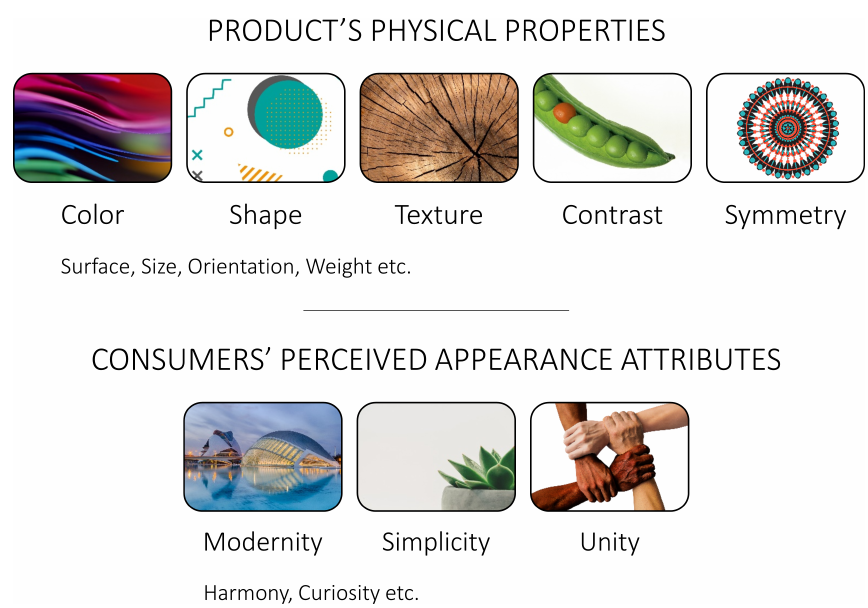
Figure 2. Examples for product’s physical properties and the perceived